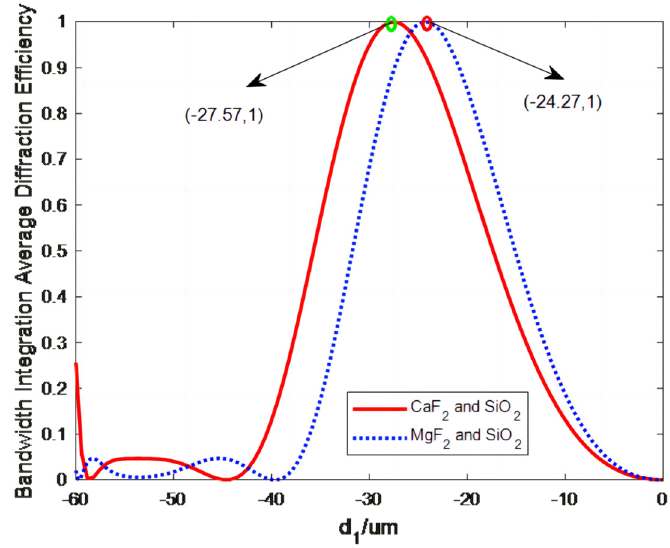
Figure 3. Relationship between BIADE and the microstructure height d 1 of double-layer DOEs. The optimization process yielded a combined microstructure height of − 27.57 μ m for CaF 2 and SiO 2 and − 24.27 μ m for MgF 2 and SiO 2 for a 100% diffraction efficiency. Figure 4 shows the relationship between the wavelength and BIADE obtained for three substrates consisting of different material combinations for the optimized double-layer DOEs.